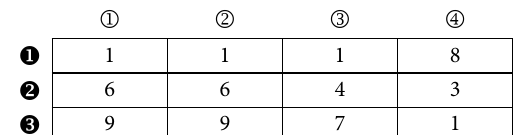
Figure. Network connecting the possible center “  ” locations and individual users “  ” Table 1. The matrix of distances among possible center “  ” locations and users “ 